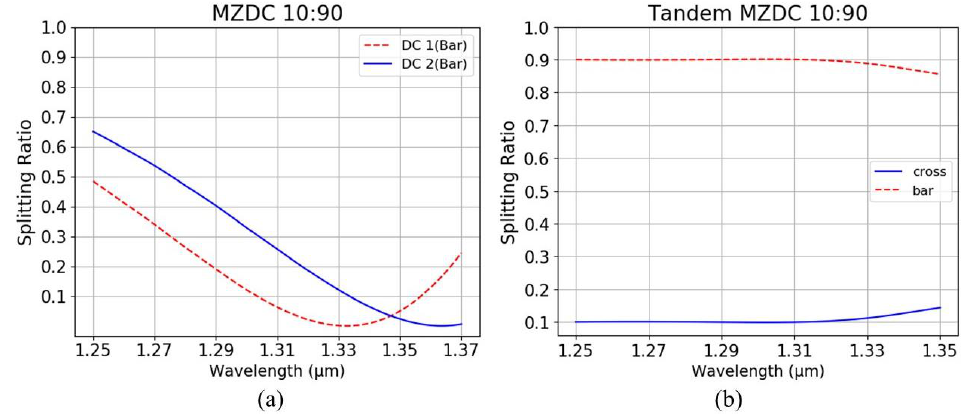
Figure 8. ( a ) Two DC splitting ratios from the MZDC structure, and ( b ) MZDC 06:94 + dL (0.52 µ m) + MZDC 25:75 from the tandem MZDC structure.